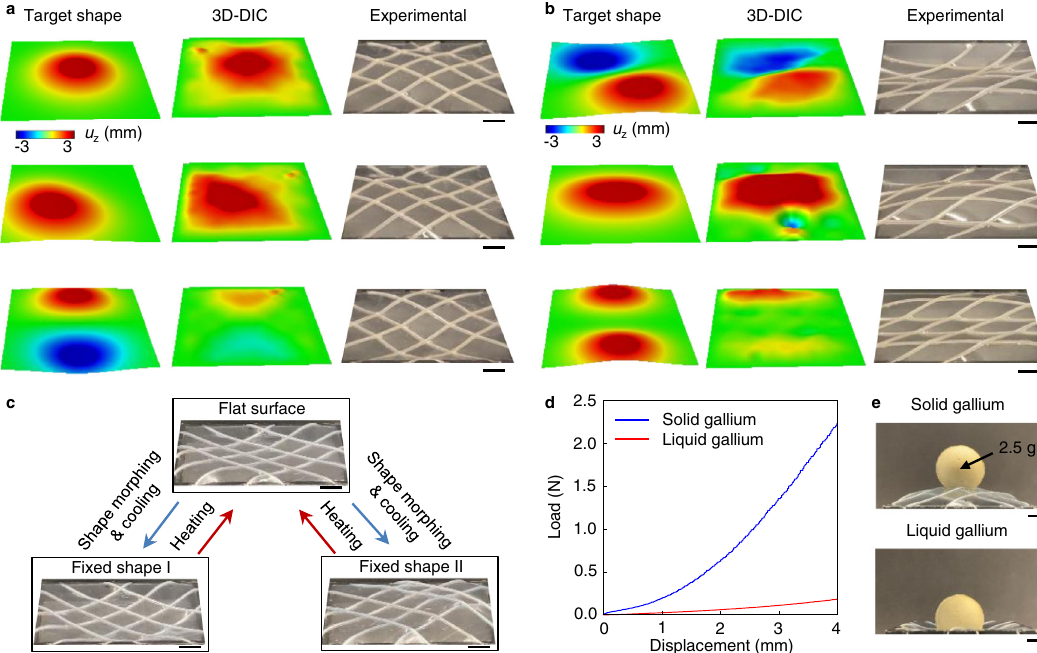
Fig. 3 Target shape programming and shape fi xation. Various target shapes realized by the programmable surfaces with 45°/ − 45° ( a ) and 0°/45° ( b ) ribbon layouts, respectively. c Shape fi xation and reprogramming utilizing liquid metal phase transition. d Experimental results of the different force – displacement response of a surface that incorporates a 4-by-4 array of gallium ribbons in solid and liquid states. e Load bearing capability of the surface with gallium ribbons in solid and liquid states. Scale bars, 5